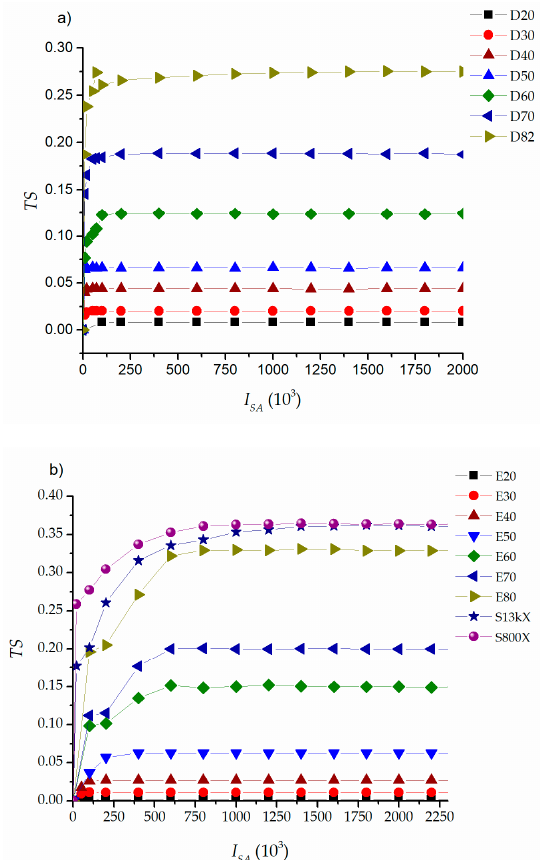
Figure 7. Comparison of TS for the matrix phase as a function of the moments I SA of the reconstruction; ( a ) TS vs. I SA for samples D and ( b ) TS vs. I SA for samples E and S.